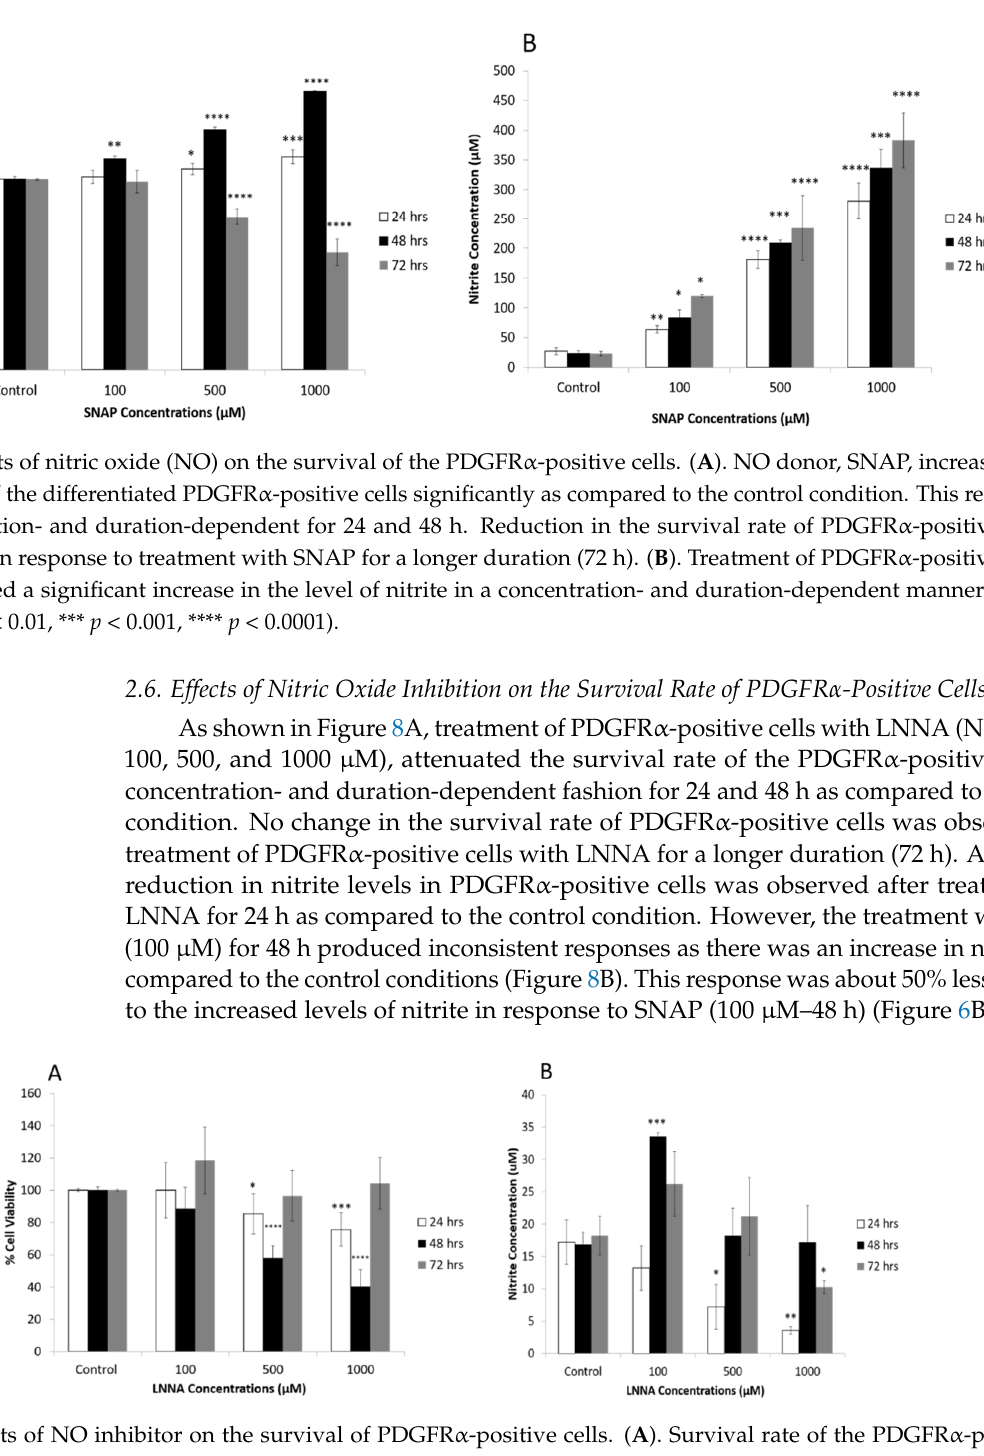
Figure 8. Effects of NO inhibitor on the survival of PDGFR α -positive cells. ( A ). Survival rate of the PDGFR α -positive cells decreased significantly in the presence of NO inhibitor, LNNA, and this response was concentration- and duration- dependent for 24 and 48 h. LNNA produced no change in the survival rate of PDGFR α -positive cells during the longer duration of 72 h. ( B ). Treatment of PDGFR α -positive cells with LNNA for 24 and 72 h produced a significant decrease in the level of nitrite and this response was concentration dependent. An increase and no change in the survival rate of PDGFR α -positive was observed during the treatment of 48 h ( n = 3, * p < 0.05, ** p < 0.01, *** p < 0.001, **** p <